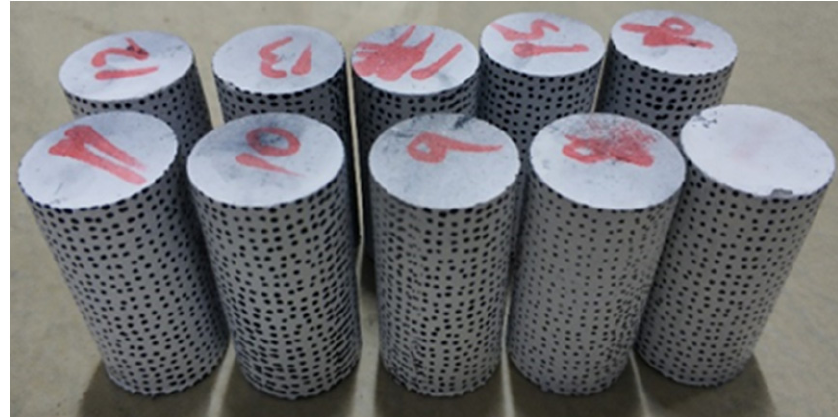
Figure 3. Specimens with speckles.